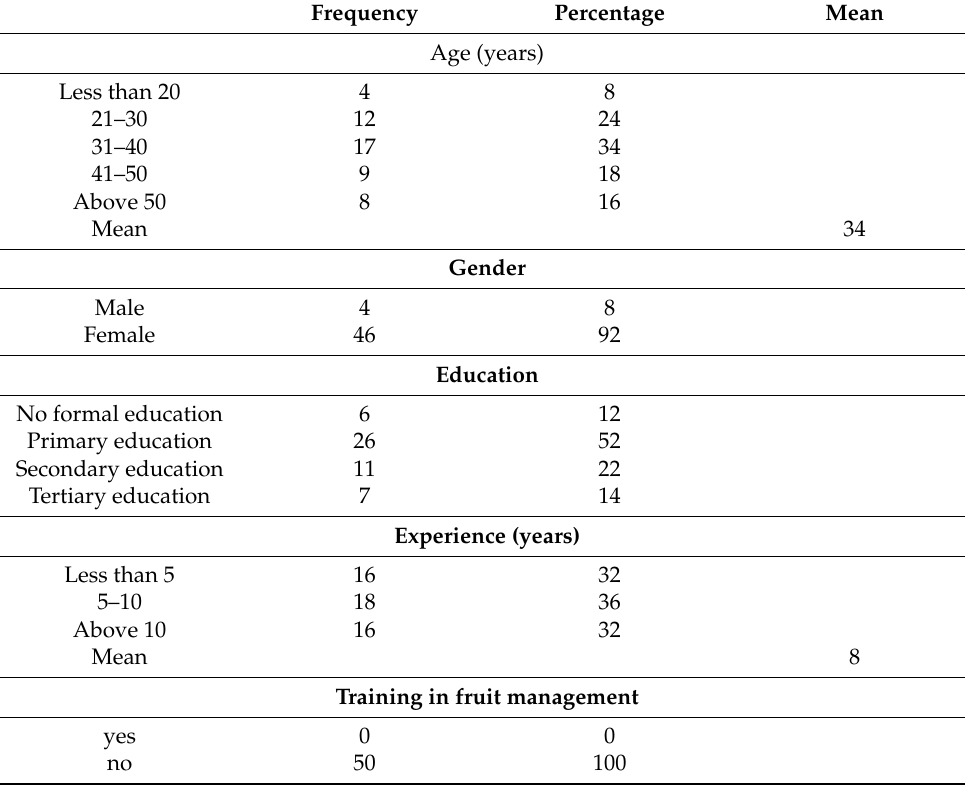
Table 1. Socioeconomic characteristics of the retailers ( n = 50).